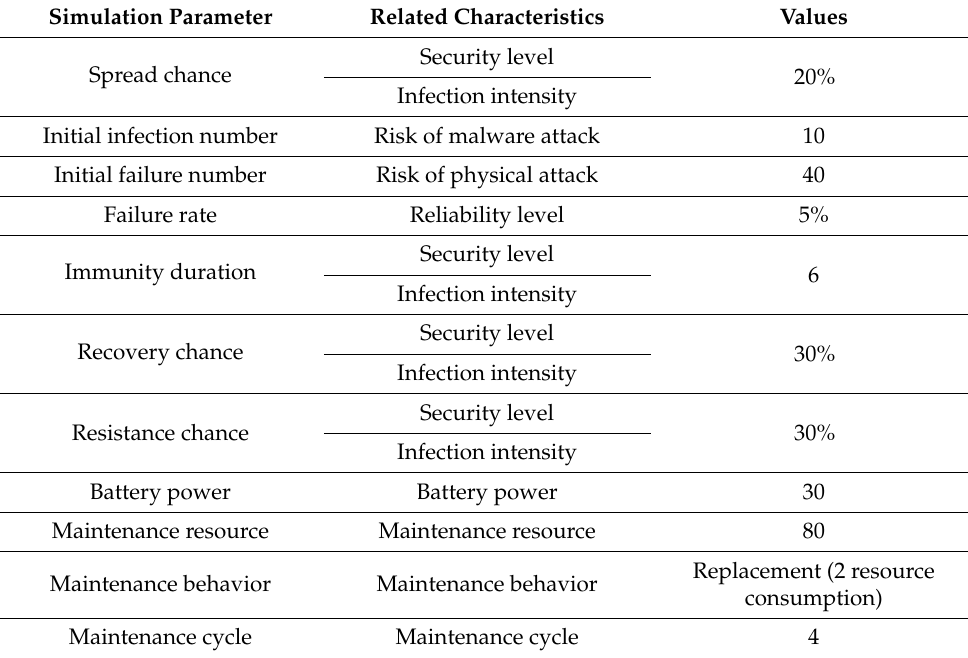
Table A3. Scenario 1 with simulation parameters and values (complex